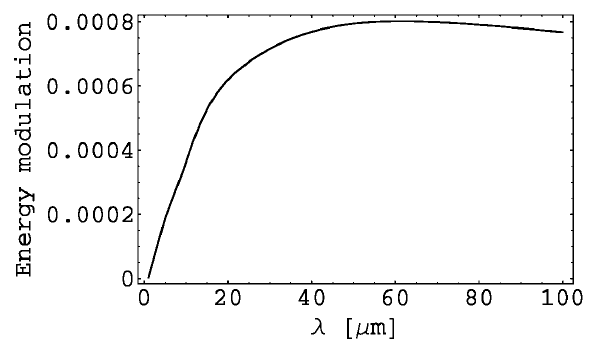
(cid:1) k ; f (cid:2)j (in units of initial bunching) as a function of modulation wavelength at the exit f 1